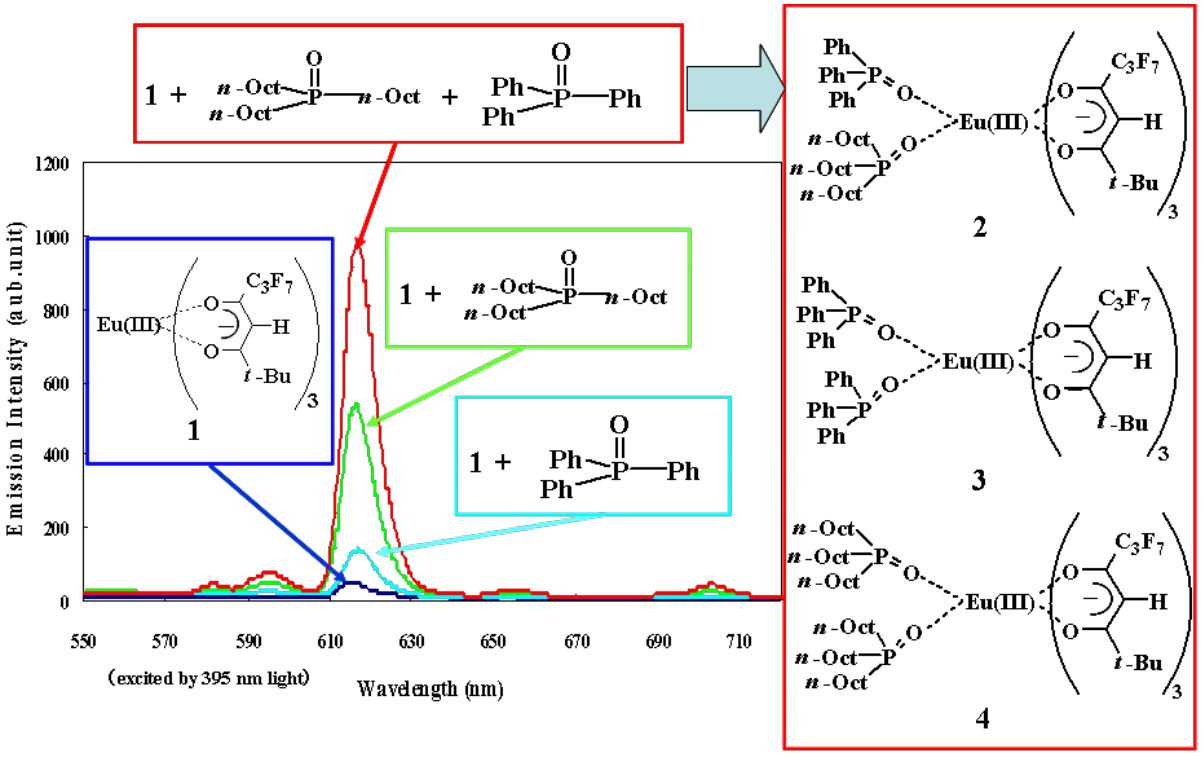
Figure 3. Emission spectra of the mixtures of Eu(III) complexes and phosphine oxides in a fluorinated solvent (2,